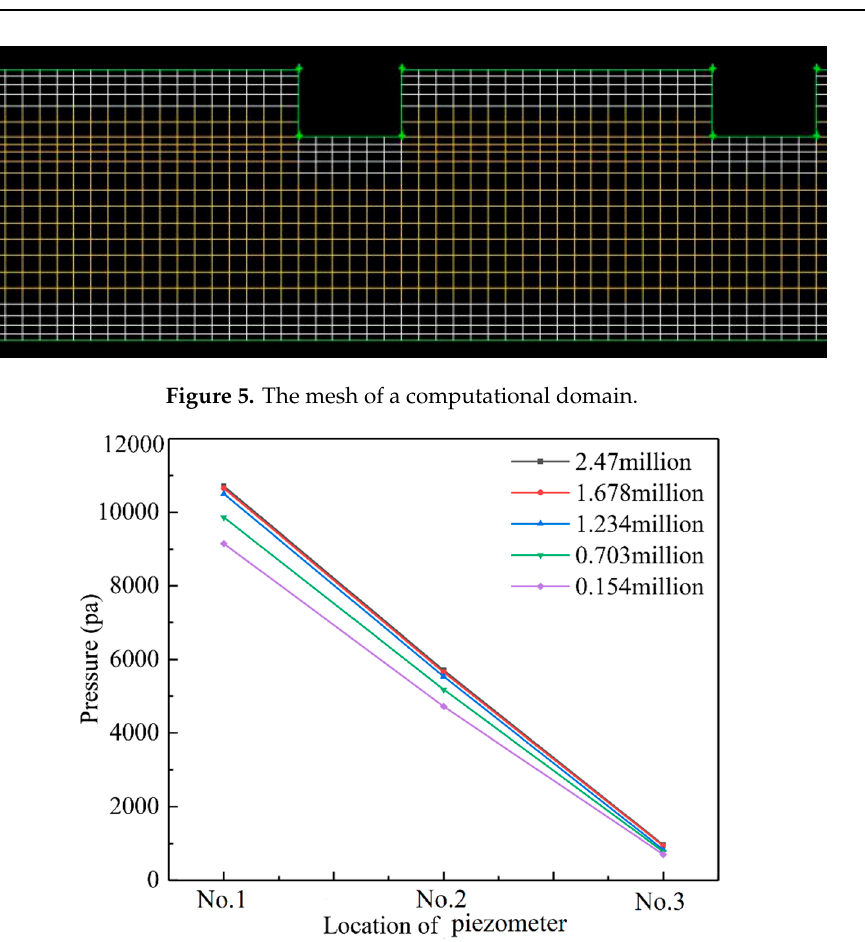
Figure 6. Comparison of pressure tap readings under five different mesh sizes.